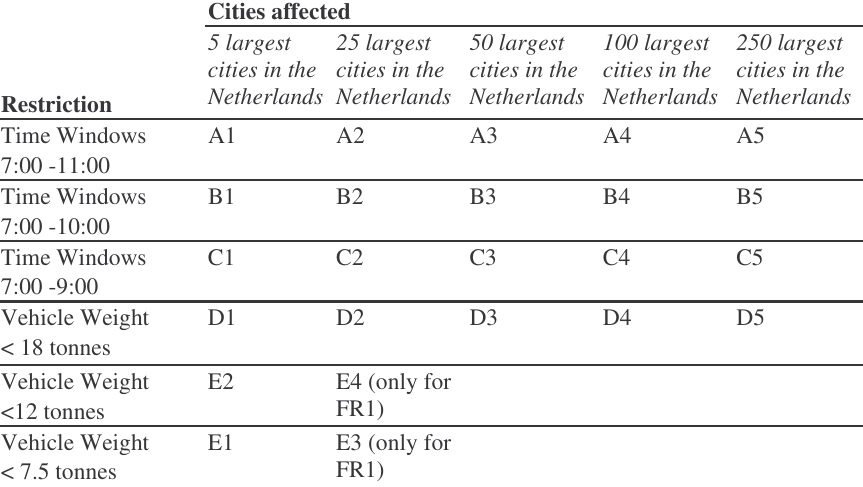
Table 2. Scenarios